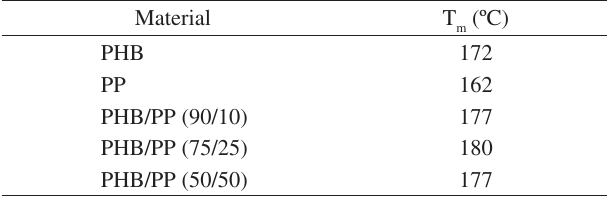
Table 3. Melting temperatures of the analyzed